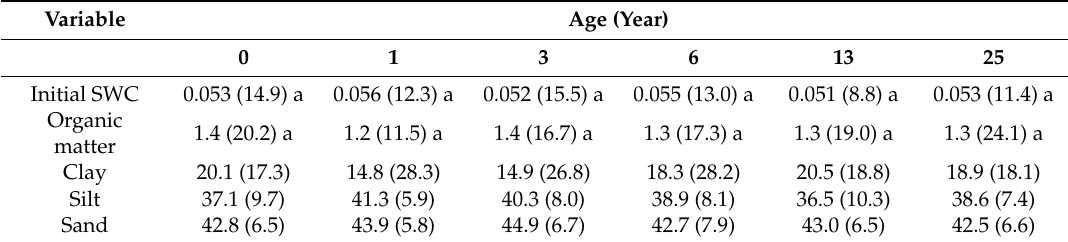
Table 1. Mean values of initial soil water content (g g − 1 ), organic matter (%), clay, silt, and sand content (%) (USDA classification system). Sample size is N = 15 for each site. Coefficient of variation (%) is in